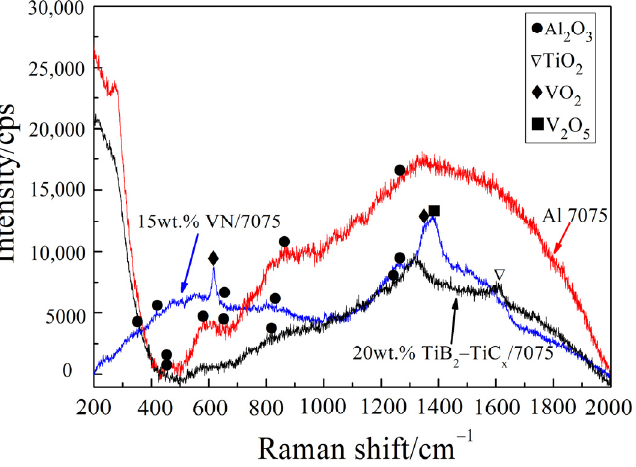
Figure 10. Raman measurement results of sample worn surface after wear test at 200 °C.